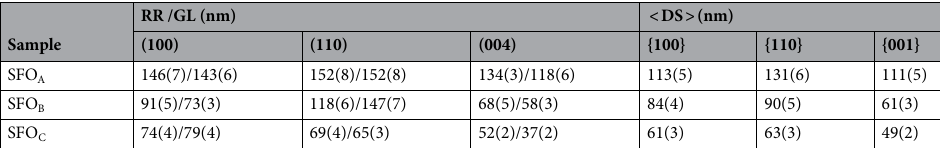
Table 2. Crystallite sizes (nm) for selected reflections from: Rietveld refinement ( RR ) and line-profile analysis ( GL ) for SFO A , SFO B , SFO C ; mean size calculated from Debye–Scherrer equation for each set of reflections ({100}, {110}, {001}) is also reported for comparison (< DS >). Uncertainties in the last digit are given in parenthesis.